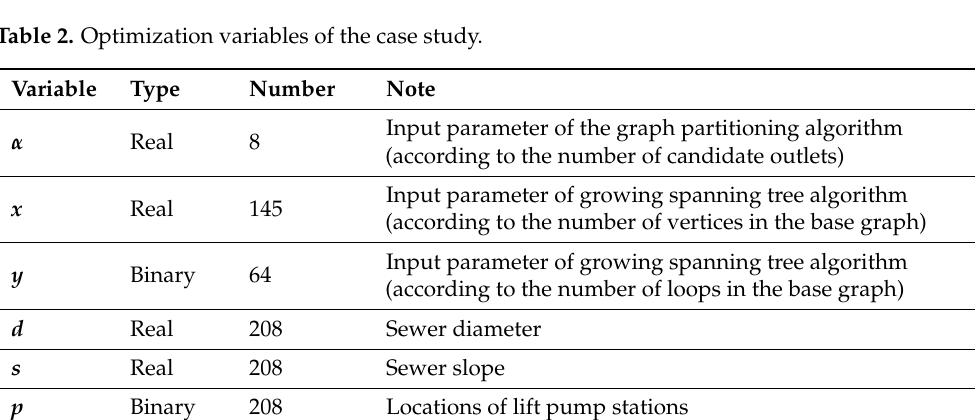
Table 2. Optimization variables of the case study.